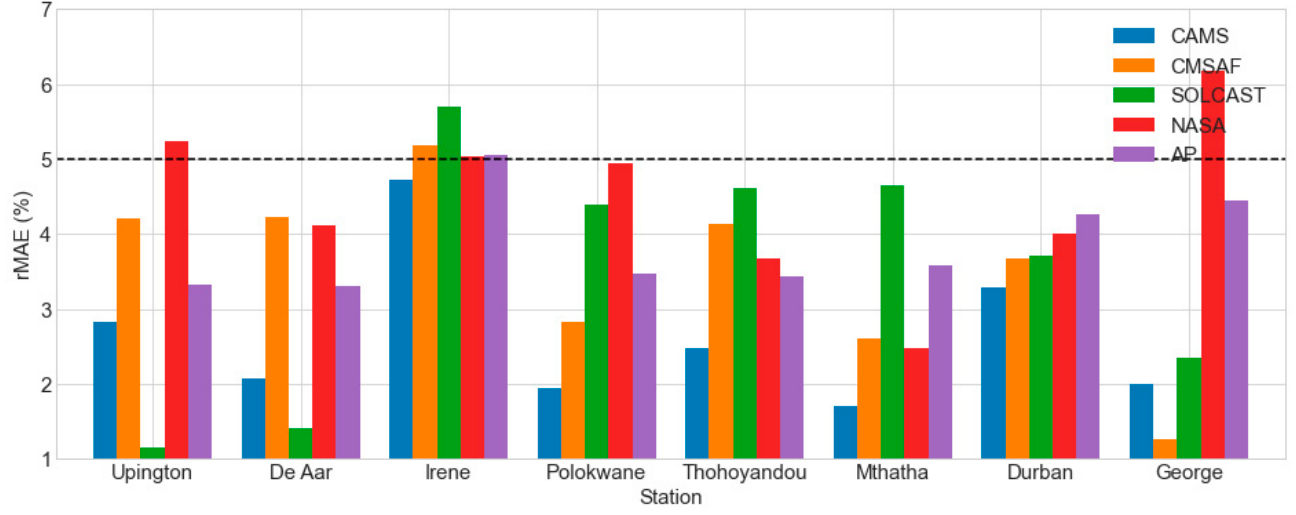
Figure 8. The daily rMAE of the estimated GHI datasets under clear-sky conditions.